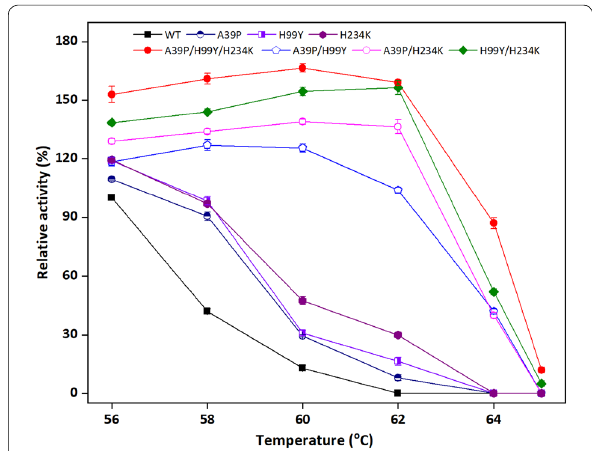
Fig. 3 Stability of wild‑type UDH and all three variants, measured by the decrease in initial activity after 10 min incubation at the temperatures indicated. 100% activity is the activity of each enzyme incubated at optimum temperature for 30 min. A39P/H99Y/H234K,